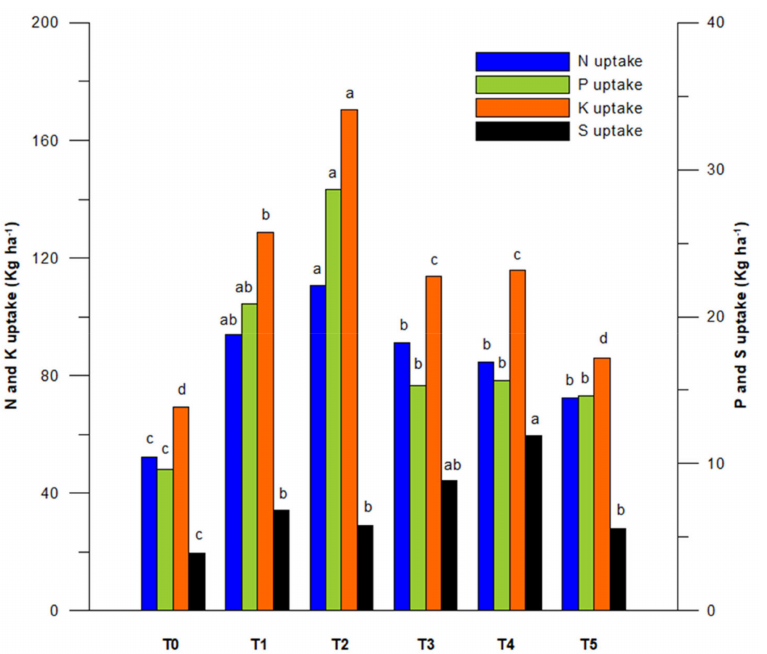
Figure 6. Effect of vermicompost on N, P, K and S uptake by BRRI dhan28 (bars having sim- ilar letter(s) are statistically similar, and those having dissimilar letter(s) differ significantly at 0.05 level of probability: T 0 , control; T 1 , mineral fertilizers only (STB); T 2 , vermicompost (10 t ha − 1 ) (IPNS) + mineral fertilizer; T 3 , cow dung (10 t ha − 1 ) (IPNS) + mineral fertilizer; T 4 , vermicompost (20 t ha − 1 ) (IPNS) + mineral fertilizer; T 5 , vermicompost (farmer’s practice) + mineral fertilizer.